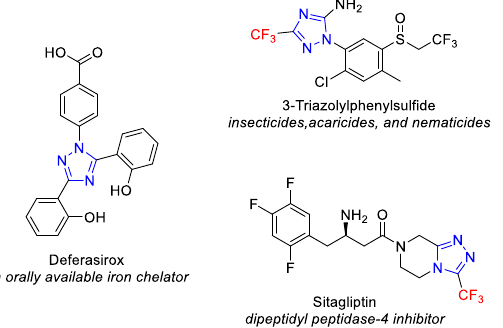
Figure 1. Representative examples of potent molecules bearing 1,2, 4-triazole scaffold.